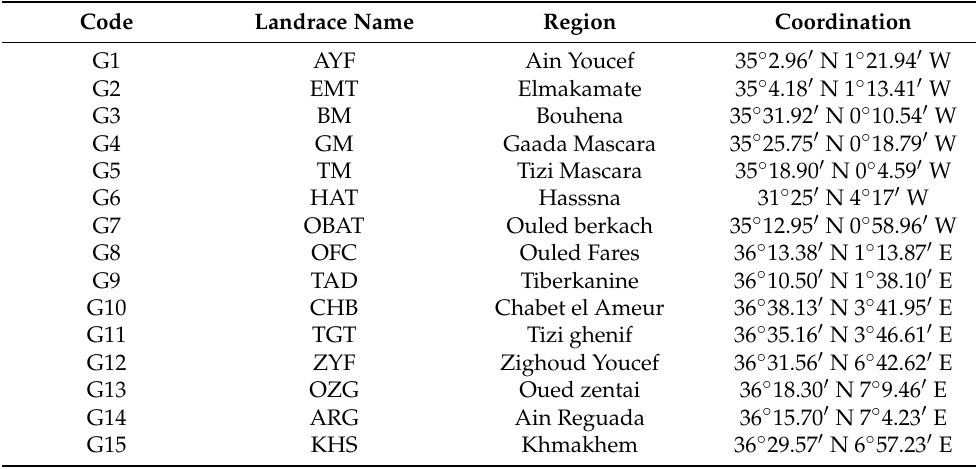
Table 1. The landraces materials and their